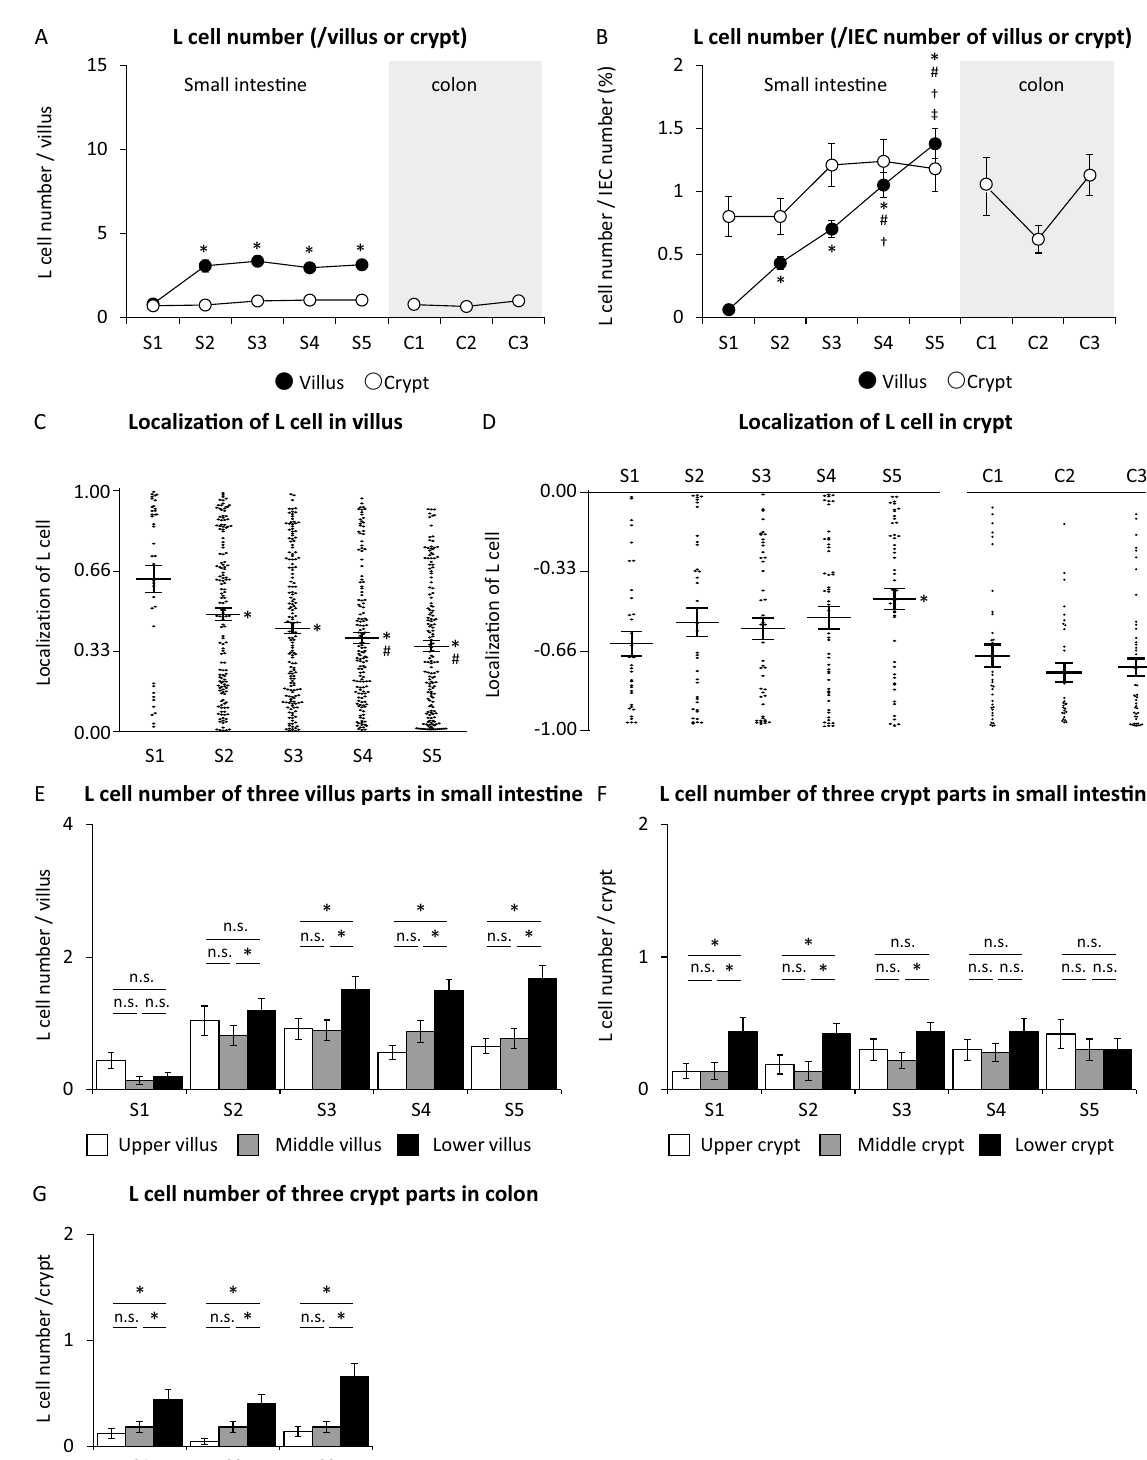
Figure 5. L cell number and localization in villi or crypts of Villin1-Tomato+ Gcg-GFP mice. ( A ) L cell number per villus or crypt and ( B ) L cell number per intestinal epithelial cell (IEC) number in each section of villus and crypt (n = 50 villi or crypts in 5 mice). Black circle and white circle show the number and the percentage of L cells in villus and crypt, respectively. All plots and the average value of L cell localization in ( C ) 50 villi and ( D ) 50 crypts of each section. ( E ) L cell number in the upper, middle, and lower villus of small intestine. ( F ) L cell number in the upper, middle, and lower crypt of small intestine. ( G ) L cell number in the upper, middle, and lower crypt of colon. (n = 50 villi or crypts in 5 mice). *P < 0.05 vs. S1, # P < 0.05 vs. S2, † P < 0.05 vs. S3, ‡ P < 0.05 vs. S4. n.s. not